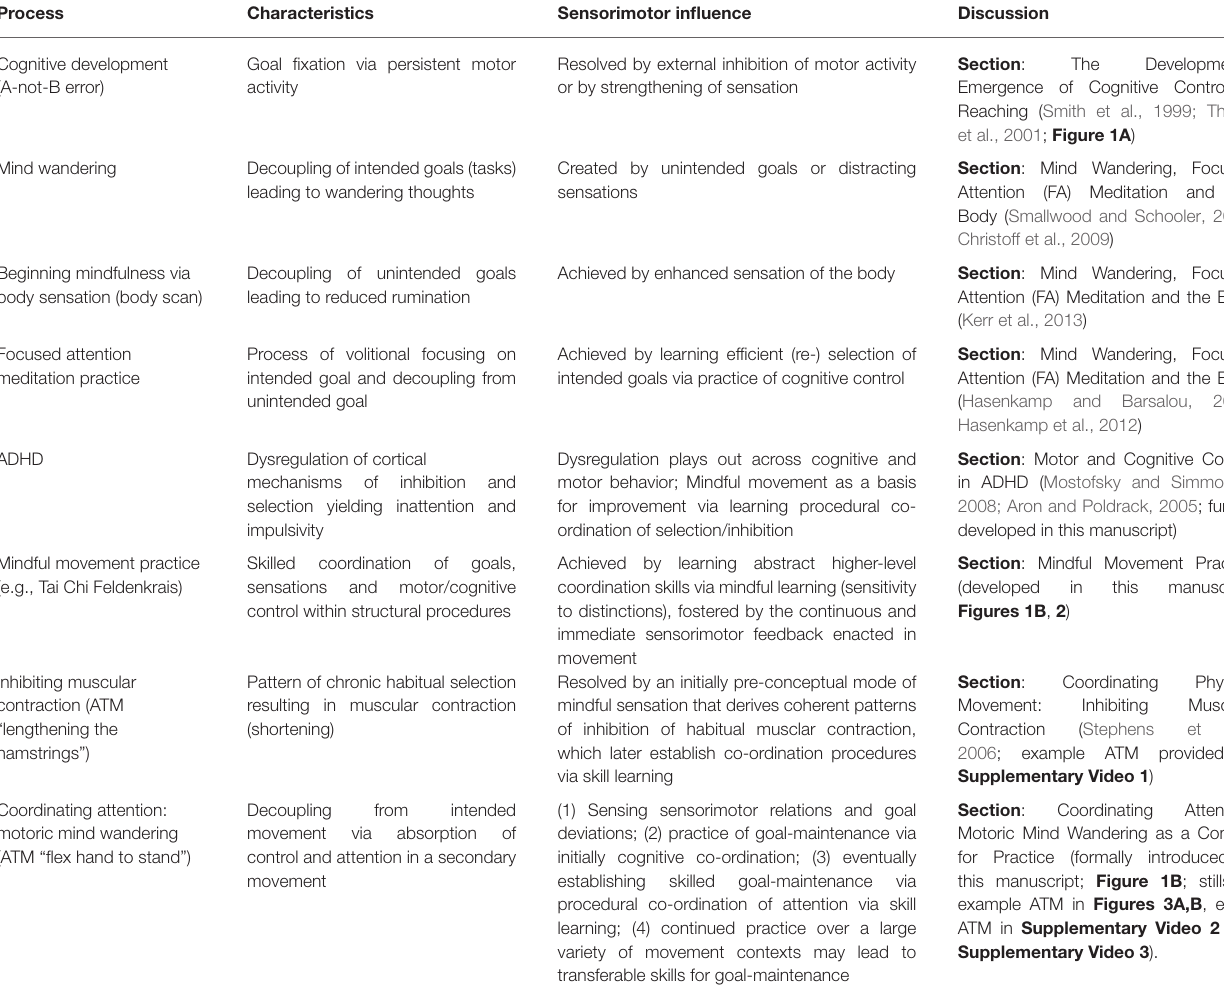
TABLE 1 | Attentional and cognitive control as coordinated sensorimotor processes